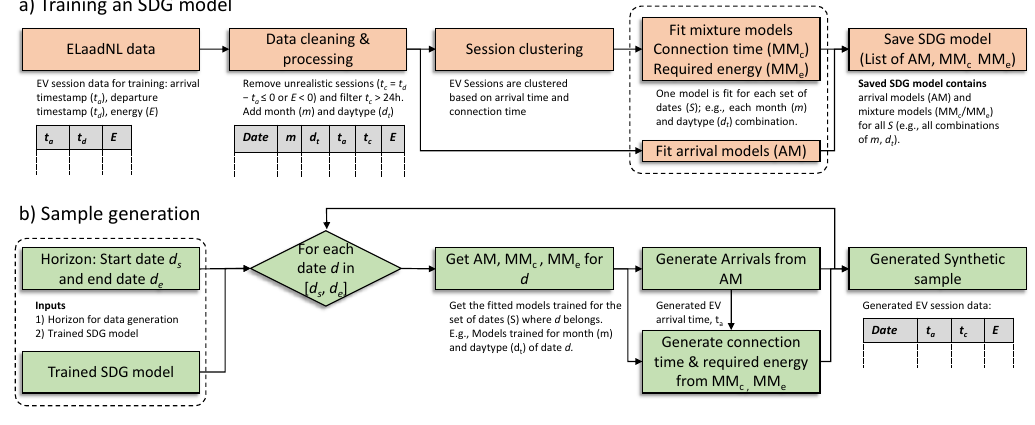
Figure 1. Modeling methodology for ( a ) training SDG models, and ( b ) generating synthetic